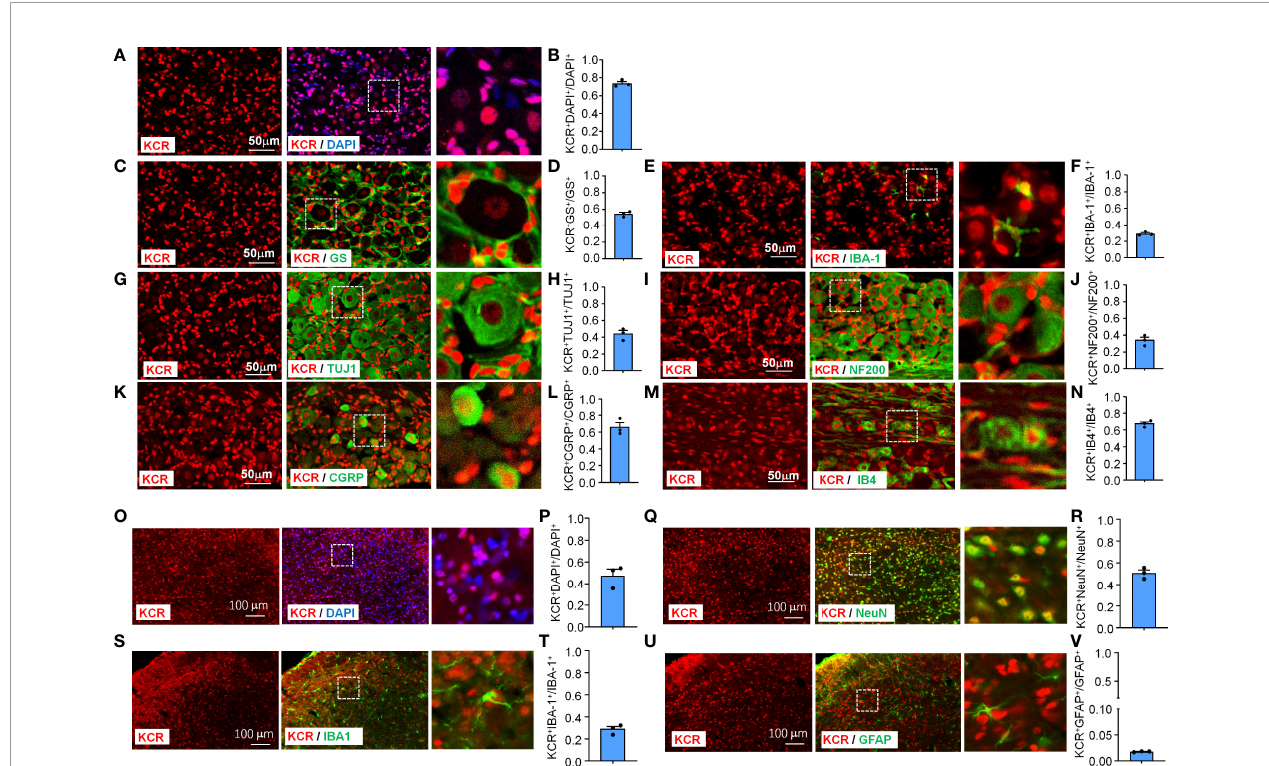
FIGURE 1 | Immuno fl uorescence detection of KCR distribution and expression in TG (Scale bar, 50 m m) and medulla oblongata (Scale bar, 100 m m). The boxed region of the merged images was enlarged on the right. Bar graphs represent ratios plotted as mean ± SEM, n = 3 sections per mouse from 3 mice per group. (A, B) DAPI and KCR staining show the ratio of KCR-positive cells to all cells in TG. (C – H) Double staining immuno fl uorescent images show the distribution of KCR in satellite cells ( GS, C, D) , macrophages ( IBA – 1, E, F) and sensory neurons ( TUJ1, G, H) in TG of naive mice. The results showed that KCR occurs in neurons, satellite cells and microglia. (I – N) Immuno fl uorescent images show colocalization of KCR with NF200 ( large myelinated neuron marker, I, J) , CGRP ( small peptidergic neuron marker, K, L) and IB4 ( small, nonpeptidergic neuron marker, M, N) in TG of naive mice. The results showed that KCR was mainly colocalized with small and medium neuron markers and a minority with large size neuron markers. (O, P) DAPI and KCR staining show the ratio of KCR-positive cells to all cells in the medulla oblongata. (Q – V) Representative photomicrographs show double fl uorescence labeling directed to KCR (red)/NeuN ( green, sensory neuron marker, Q, R) , KCR/IBA- 1 ( green, microglia marker, S, T) and KCR/GFAP ( green, astrocyte marker, U, V) in the medulla oblongata, scale bar = 100 m m. The results showed that KCR was colocalized primarily with neurons and microglia and a minority with